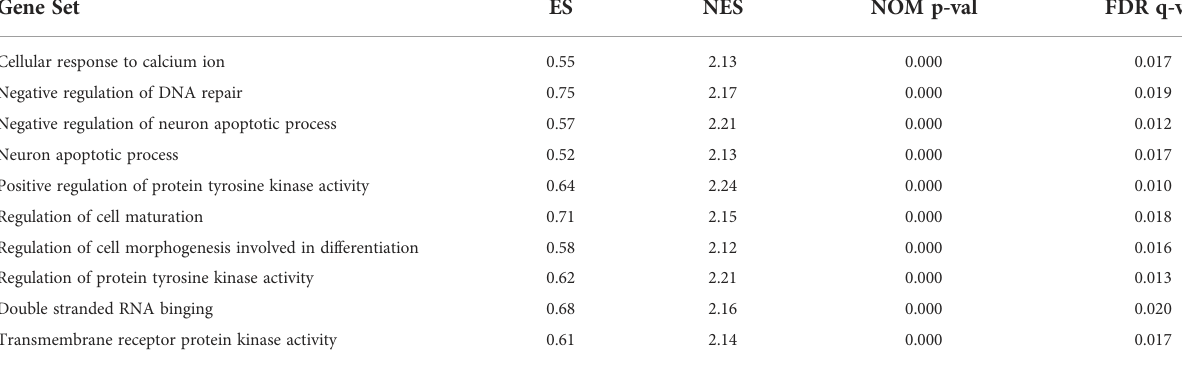
TABLE 2 The high-risk group enriched gene sets by GO